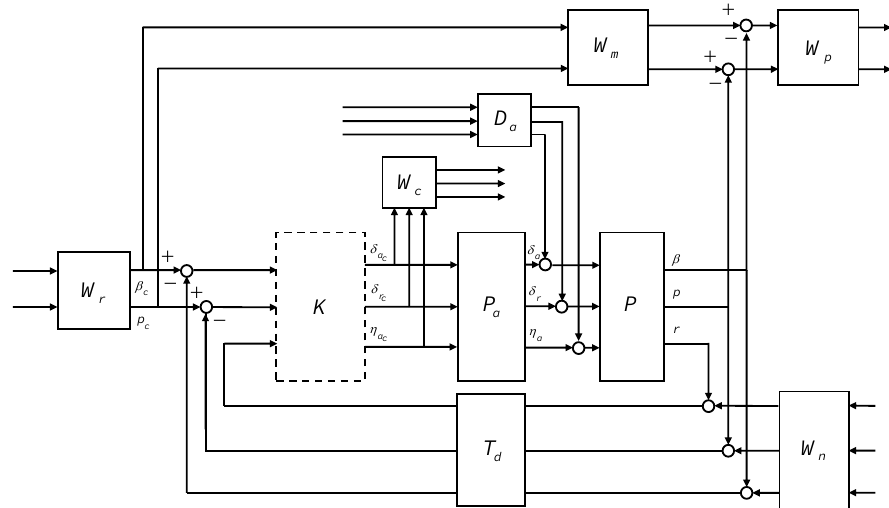
Figure 9. Closed-loop interconnection of the lateral-directional